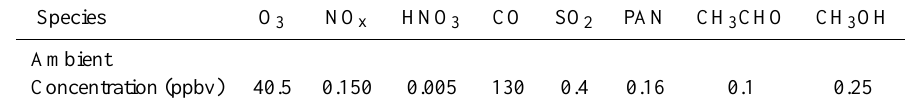
Fig. 1. Observed and simulated concentrations averaged over the cross-section of a ship plume released at 12:00h local time as function of time since release for the species: (a) NO x ; (b) O 3 ; (c) OH and (d) the NO x instantaneous lifetime as function of time. The solid line indicates the PARANOX simulation with ambient concentrations given in Table 2. The dashed line represents the background concentration and the squares represent the observations taken during the ITCT 2002 aircraft campaign on 8 May 2002, with the bars indicating measurement errors. The OH concentrations in (c) were inferred from H 2 SO 4 measurements (Chen et al., 2005). The NO x instantaneous lifetime was calculated as the NO x concentration divided by the production rate of HNO 3 at any point in time.